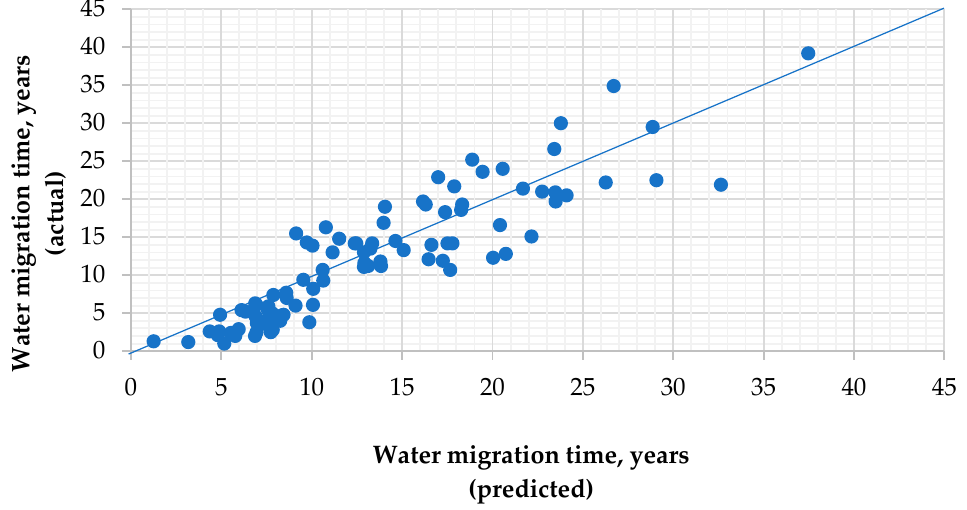
Figure 9. Comparison of predicted and actual values of the water migration time.